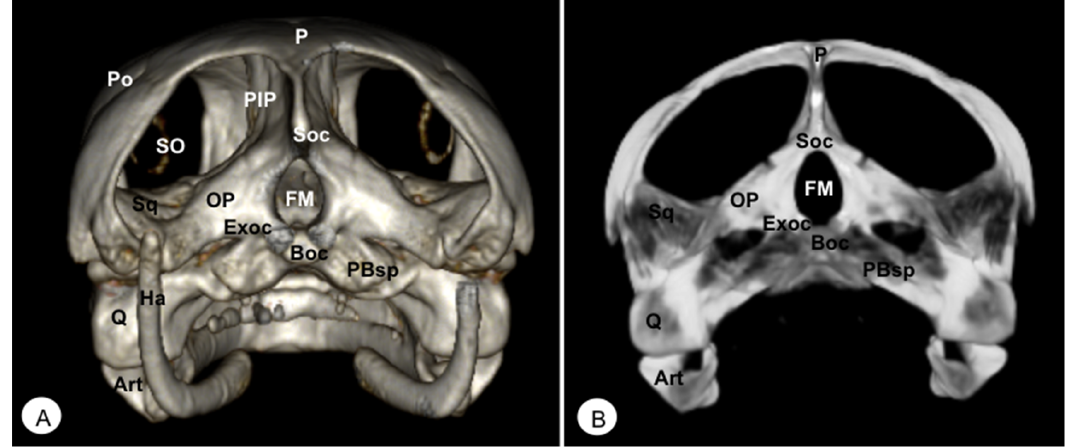
Figure 6. Head of Caretta caretta . ( A ) Caudal VR image. ( B ) Caudal MIP image. P: Parietal bone. PIP: Procesus inferior parietalis. Po: Postorbital. Sq: Squamosal bone. Soc: Supraoccipital bone. Exoc: Exoccipital bone. Boc: Basioccipital bone. OP: Opisthotic bone. FM: Foramen magnum. PBsp: Parabasisphenoid bone. SO: Scleral ossifications. Q: Quadrate. Art: Articular. Ha: Hyoid apparatus.